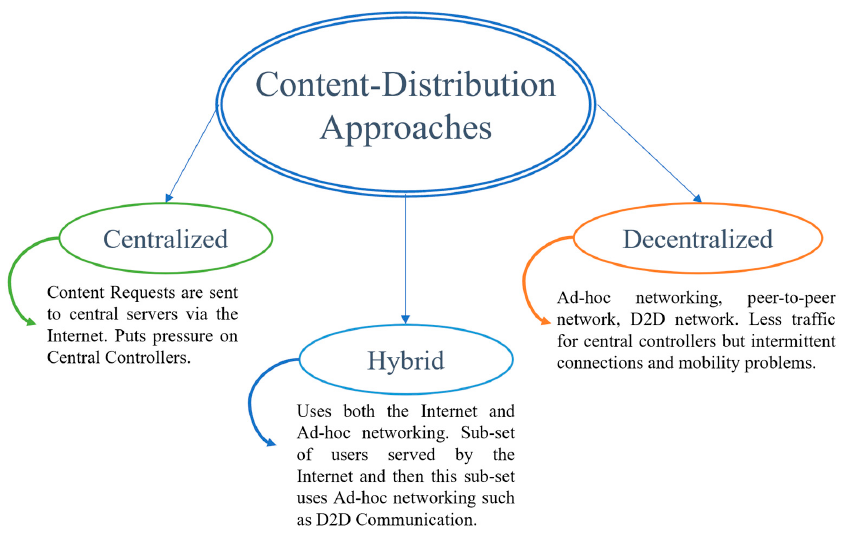
Figure 1. Summary of content distribution approaches.